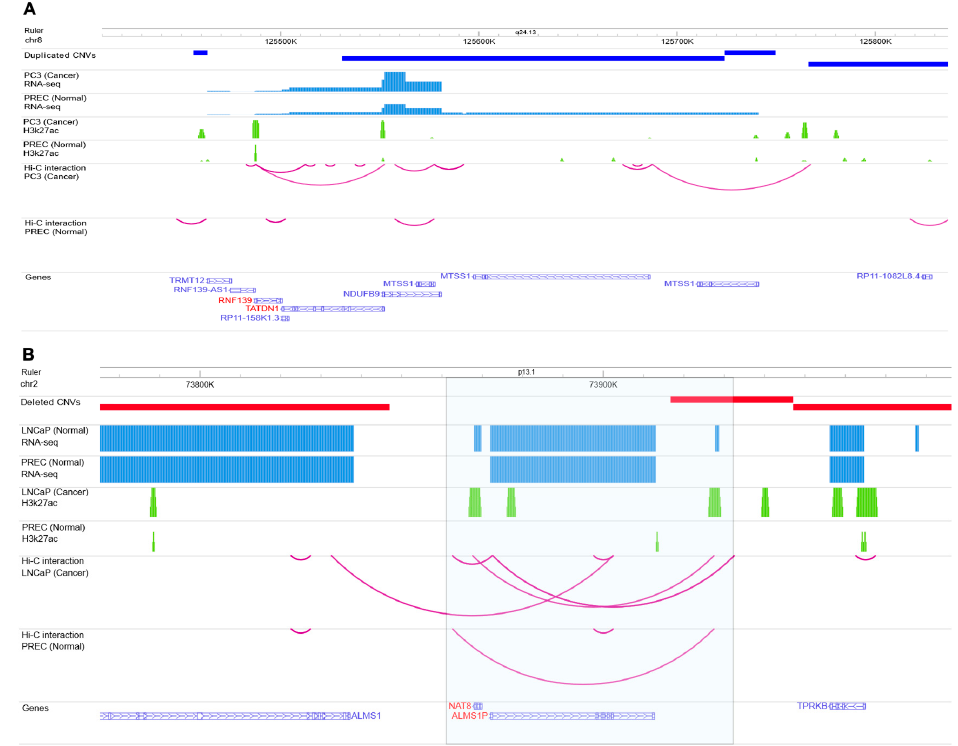
Figure 7. ( A ) Example of a regulatory variant in cancer cell line PC3. The figure demonstrates the RNA-Seq, H3K27ac signals, and Hi-C chromatin interactions map of normal (PREC) and prostate cancer (PC3) cells on Chromosome 8. The highlighted box shows one of the PC-associated CNVRs identified in this study that was also observed in PC3 WGS. There is an EPI in the cancer cell line (the EPI was not observed in the healthy cell line) where the enhancer side of the interaction overlapped with CNVR. Interestingly, the left side of this interaction is promoter regions of RNF139 and TADN1 , and the right side (enhancer region) also has an active H3K27ac signal. The expression of NDUFB9 is much higher in the cancer cell line compared to the healthy cell line. ( B ) Example of the regulatory variant in cancer cell line LNCaP. The figure demonstrates the RNA-seq, H3K27ac signals, and Hi-C chromatin interactions map of normal (PREC) and prostate cancer (LNCaP) cells on Chromosome 2. The highlighted box shows one of the PC-associated CNVRs identified in this study that was also observed in LNCaP WGS. There is an EPI in the cancer cell line (the EPI was not observed in the healthy cell line) where the enhancer side of the interaction overlapped with CNVR. Interestingly, the left side of this interaction is promoter regions NAT8 and ALMS1P genes, and the right side (enhancer region) also has an active H3K27ac signal. WashU Epigenome Browser has been used to generate the